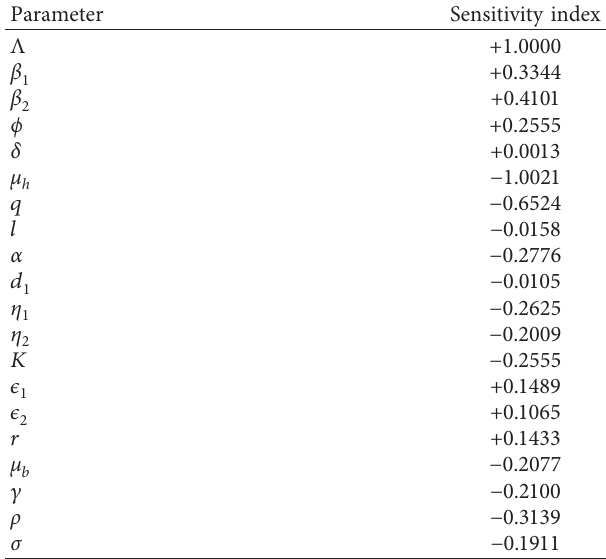
Table 3: Parameters and their sensitivity indices.